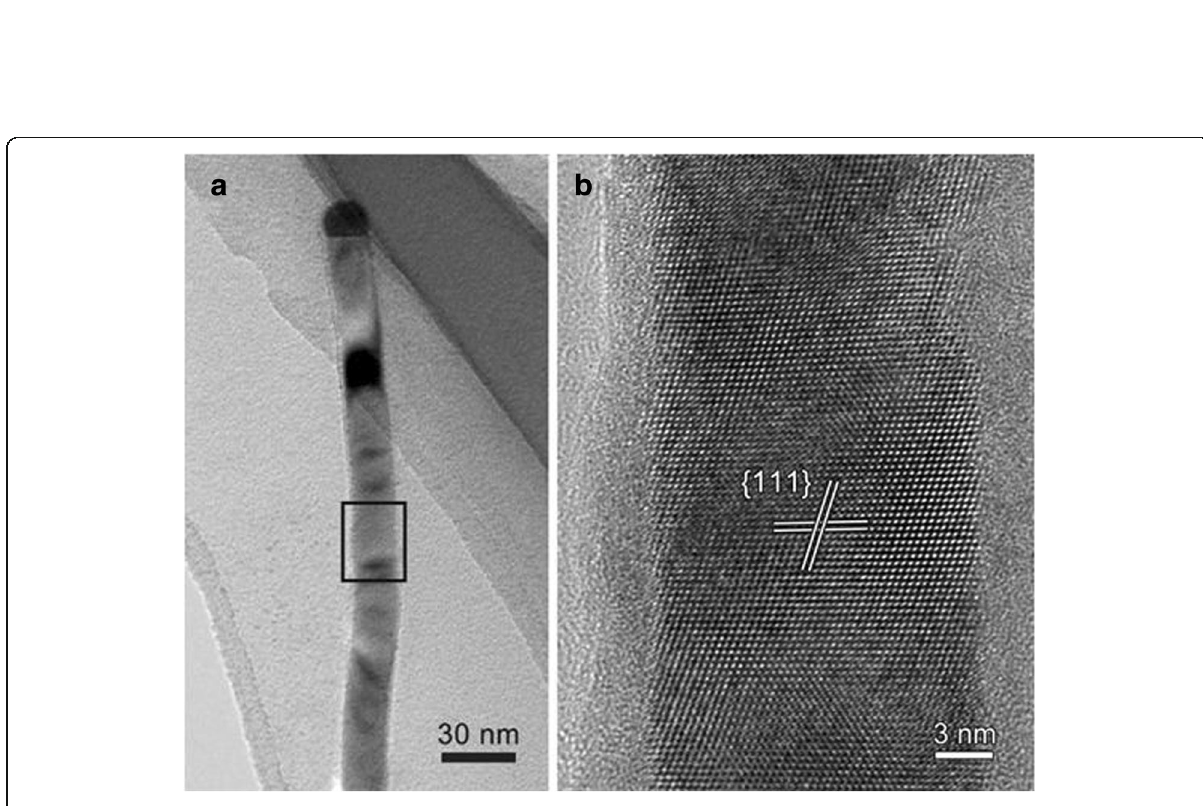
Fig. 5 a Bright-field TEM image of the NW with a smooth surface. b HRTEM image of the rectangle area marked out in